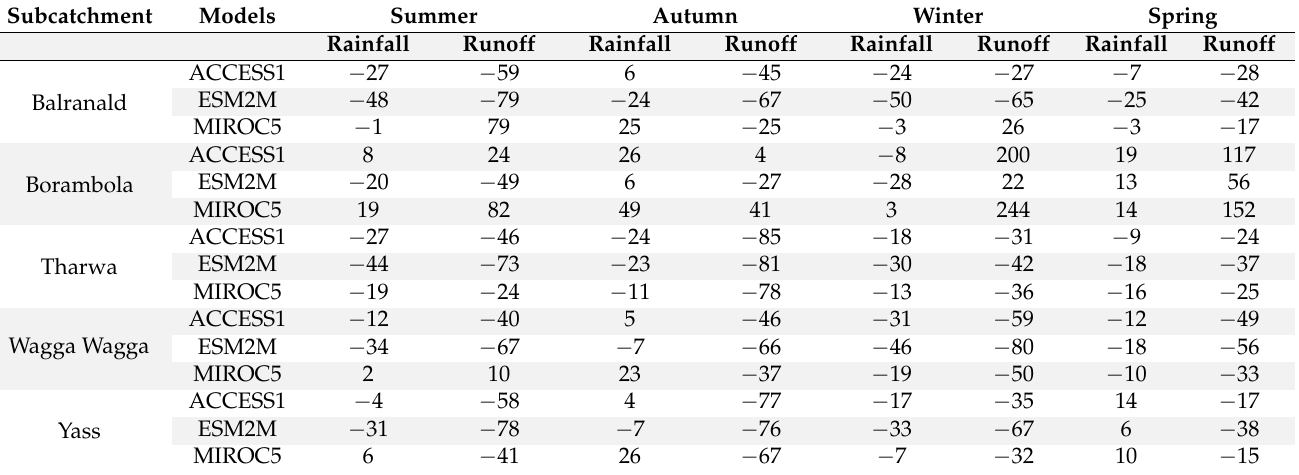
Table 8. Seasonal change (%) of rainfall and simulated runoff for RCP 8.5 at sub-catchments of Murrumbidgee River